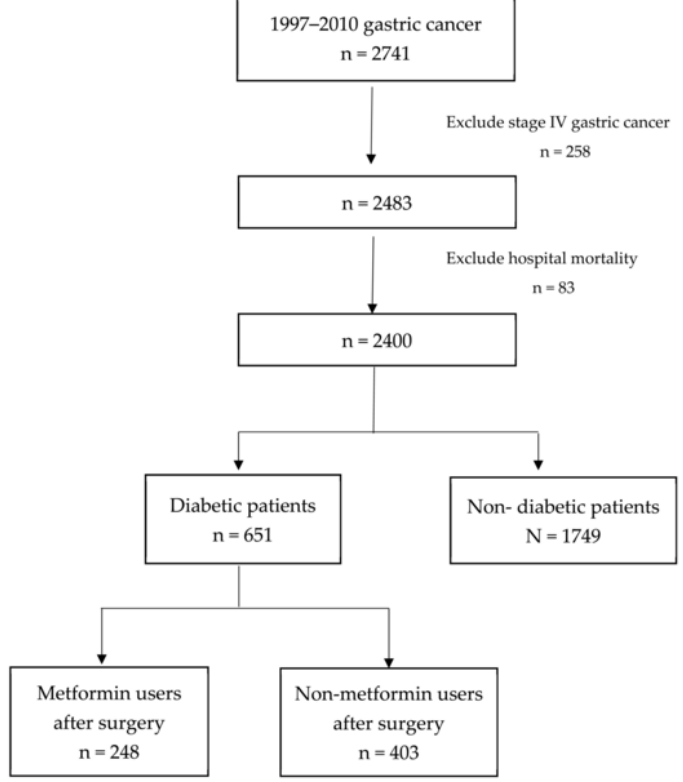
Figure 1. Flowchart of patients with stage I–III gastric cancer (GC) undergoing gastrectomy recruited in the study.